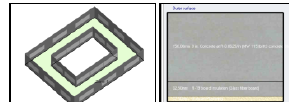
Figure 4. Courtyard and building shell section modeled with DesignBuilder (DB version 5) [45]. Table 5. Building crust and thermophysical properties in investigated houses.